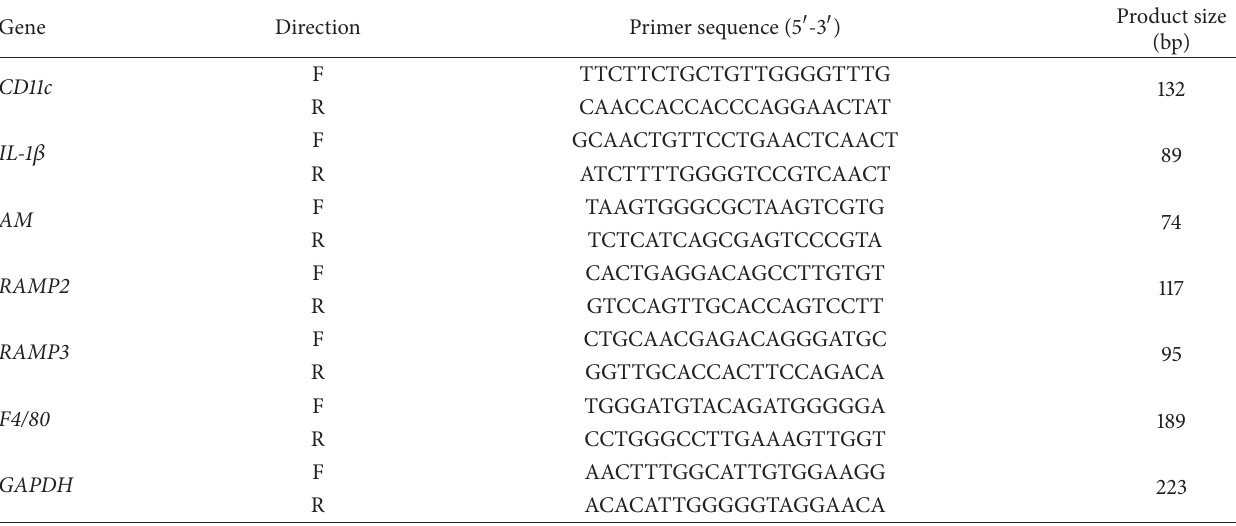
Table 1: Sequences of the primers used in this